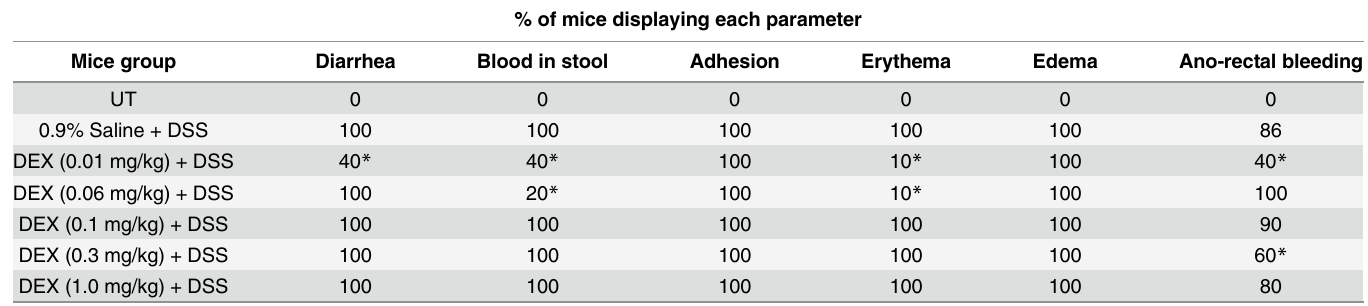
Table 3. Effect of DEX on macroscopic features of colitis when administered simultaneously with